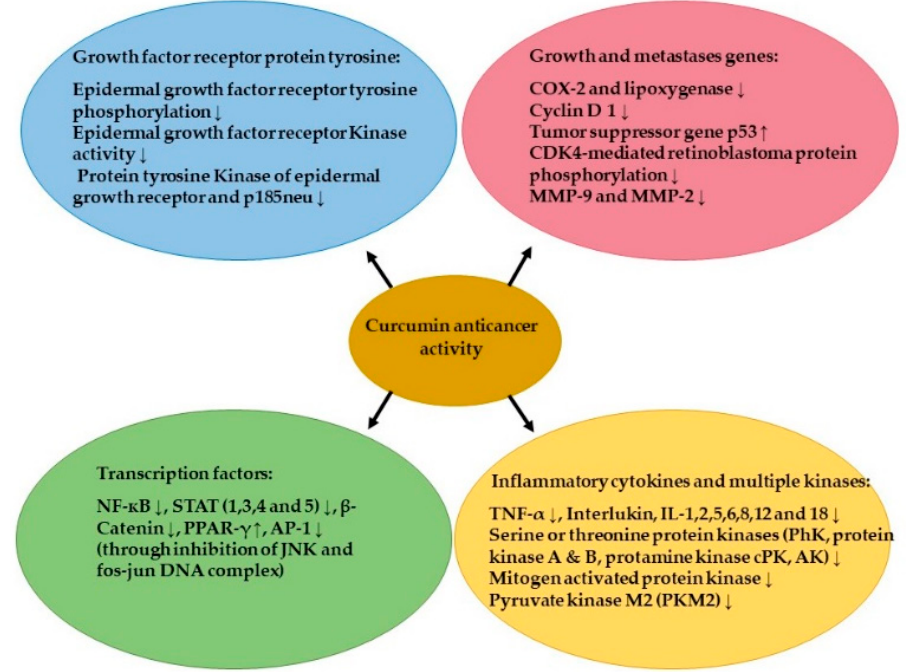
Figure 6. The main molecular targets of curcumin in cancer cells. ↑ : Increase; ↓ : Decrease; MMP: Matrix metalloproteinase; AP-1: Activation protein-1.